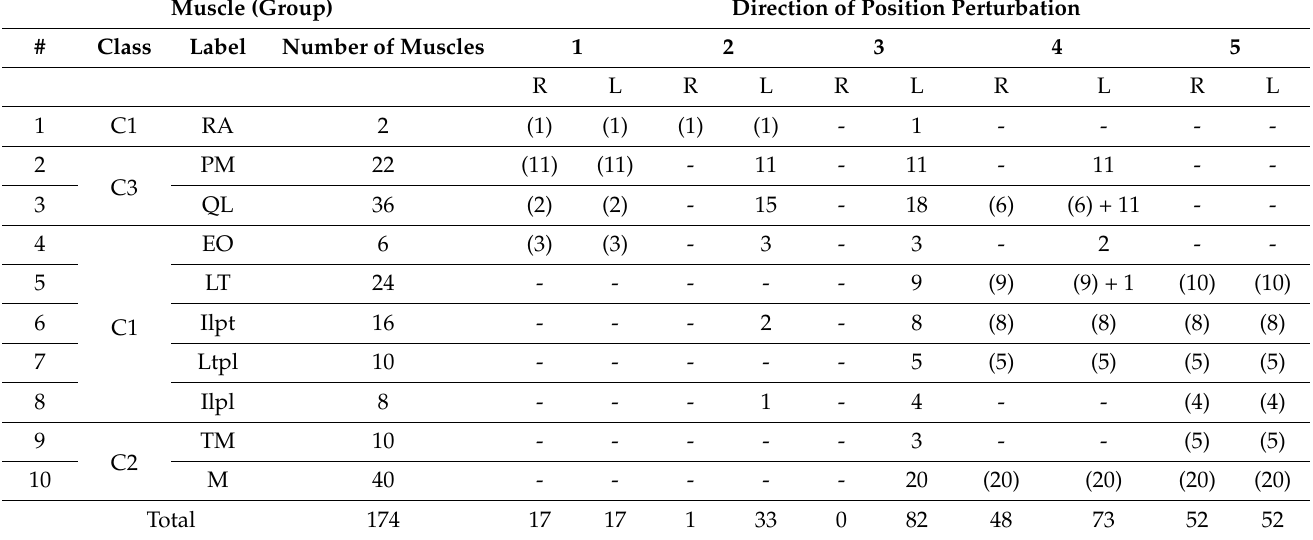
Table A1. Number of shortened muscles for the five